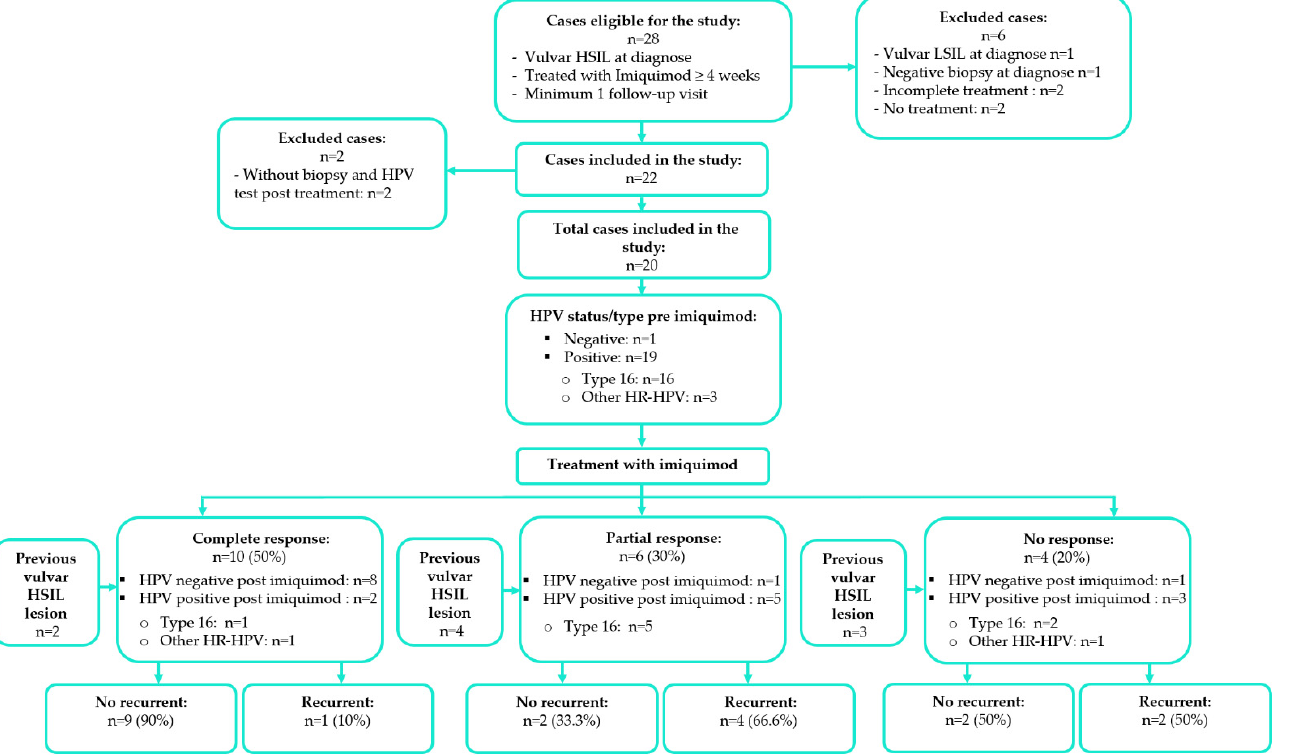
Figure 1. Study inclusion and exclusion of patients treated with imiquimod for vulvar high-grade squamous intraepithelial lesion (vulvar HSIL). Different types of response after imiquimod treatment, HPV status and type determined pre- and post-imiquimod treatment, history of previous vulvar HSIL lesions, and recurrent vulvar HSIL after imiquimod treatment. Vulvar HPV was positive in the pre ‐ treatment biopsy in 19/20 cases (95%). The only case that was HPV ‐ negative pre ‐ treatment showed a complete response. HPV type 16 was present in 16 (80%) pre ‐ treatment vulvar biopsies. Another 3 cases (15%) had either type 18, 53, or 51 HPV (Table 2) (Figure 2a).